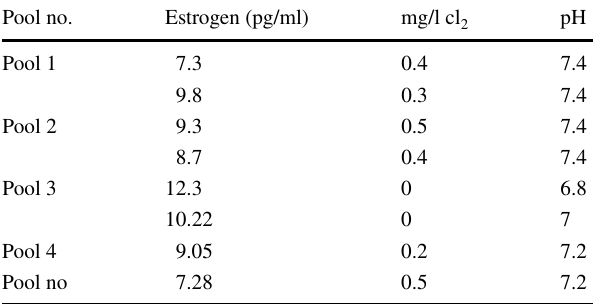
Table 3 Quality of inlet raw water into pools Pool no.